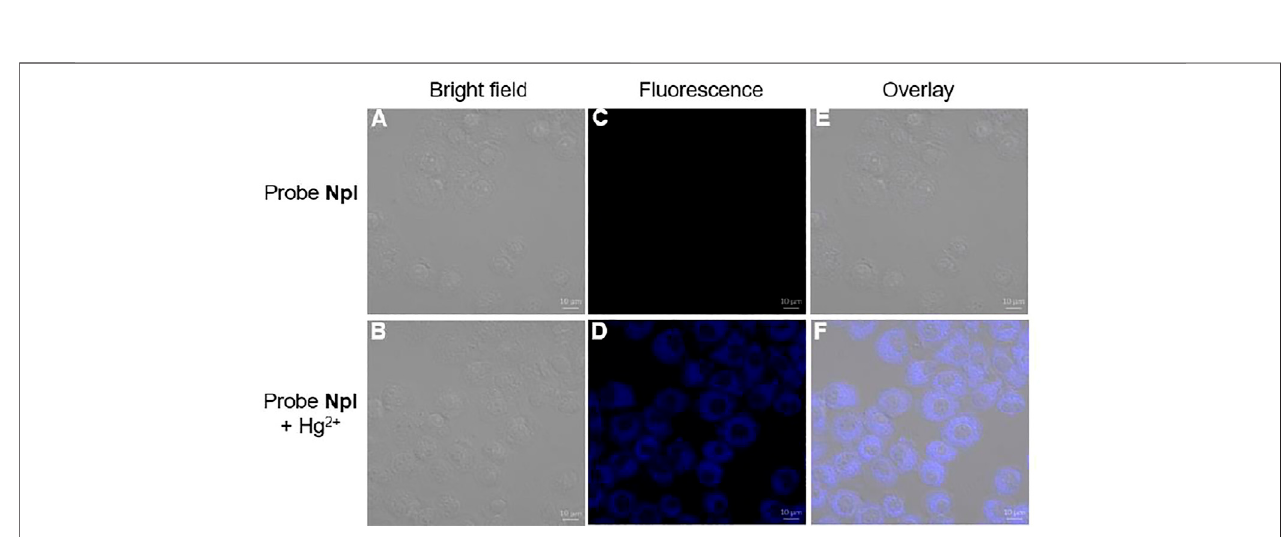
FIGURE7| FluorescentconfocalbioimagingofMCF-7cells: (A,C,E) cellsincubatedwithfreeprobe NpI , (B,D,F) imageswerecapturedafter30 minoftreatment with probe NpI and Hg 2+ , respectively. (A, B) bright- fi eld images, (C, D) fl uorescence images, (E, F) merged images.